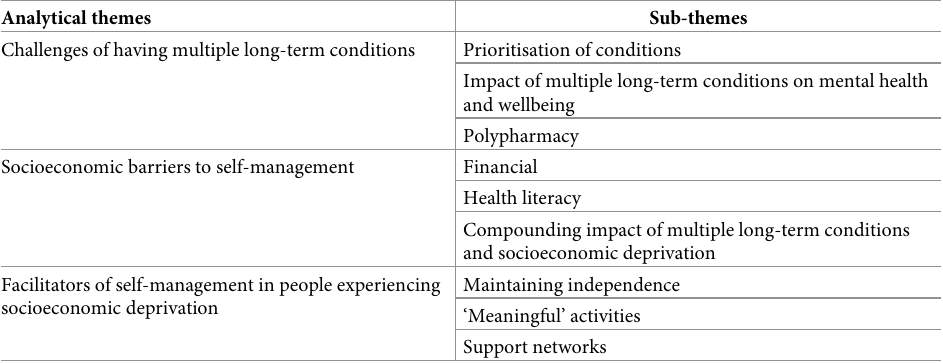
Table 2. Relationship between analytical themes and